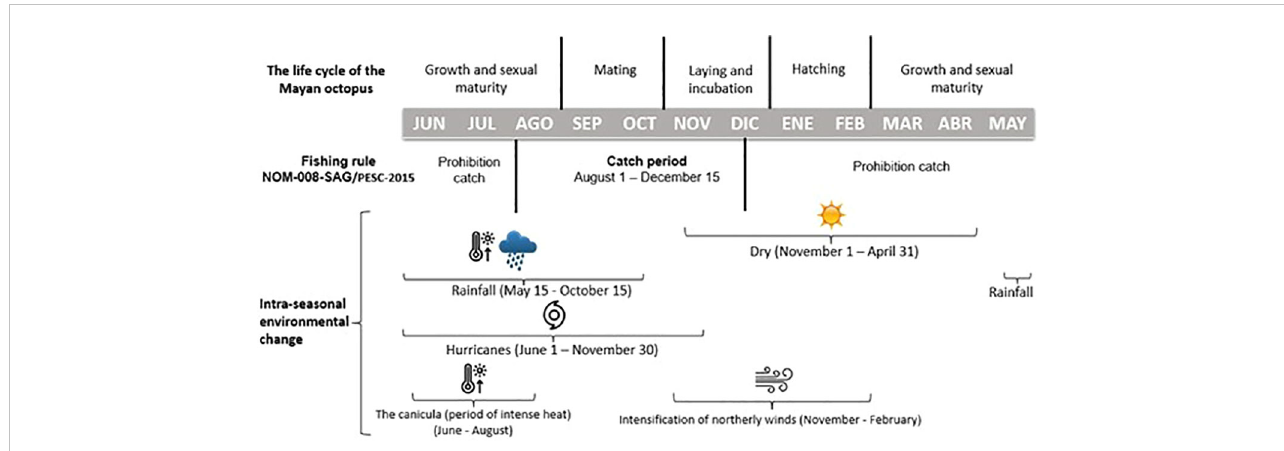
FIGURE 3 The life cycle of the Mayan octopus, intra-seasonal environmental variability, and NOM-008-SAG/PESC-2015. Own elaboration based on Sol ı ́ s-Ram ı ́ rez et al., 1997; DOF, 2019; CONAGUA,